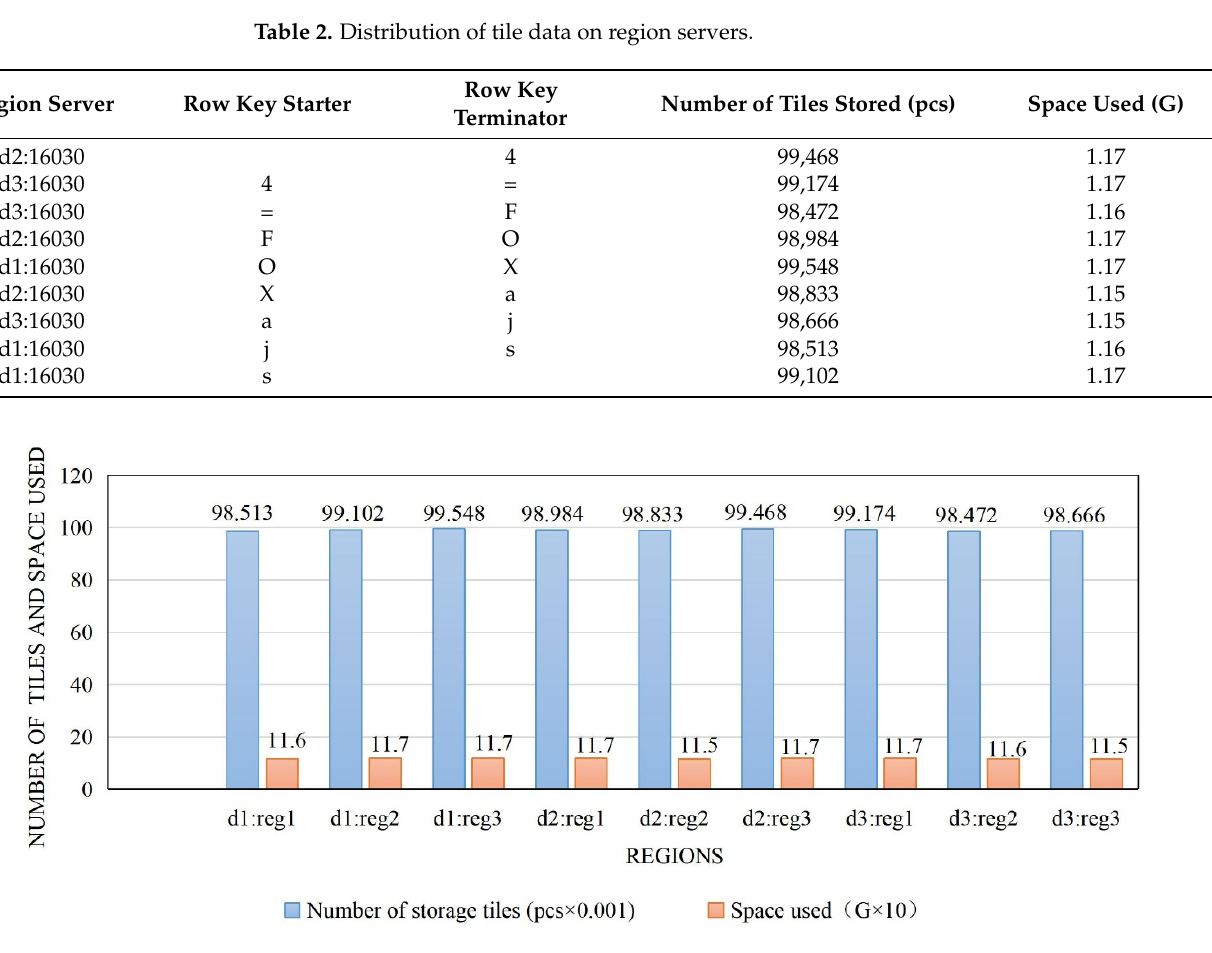
Row Key Row Key Starter